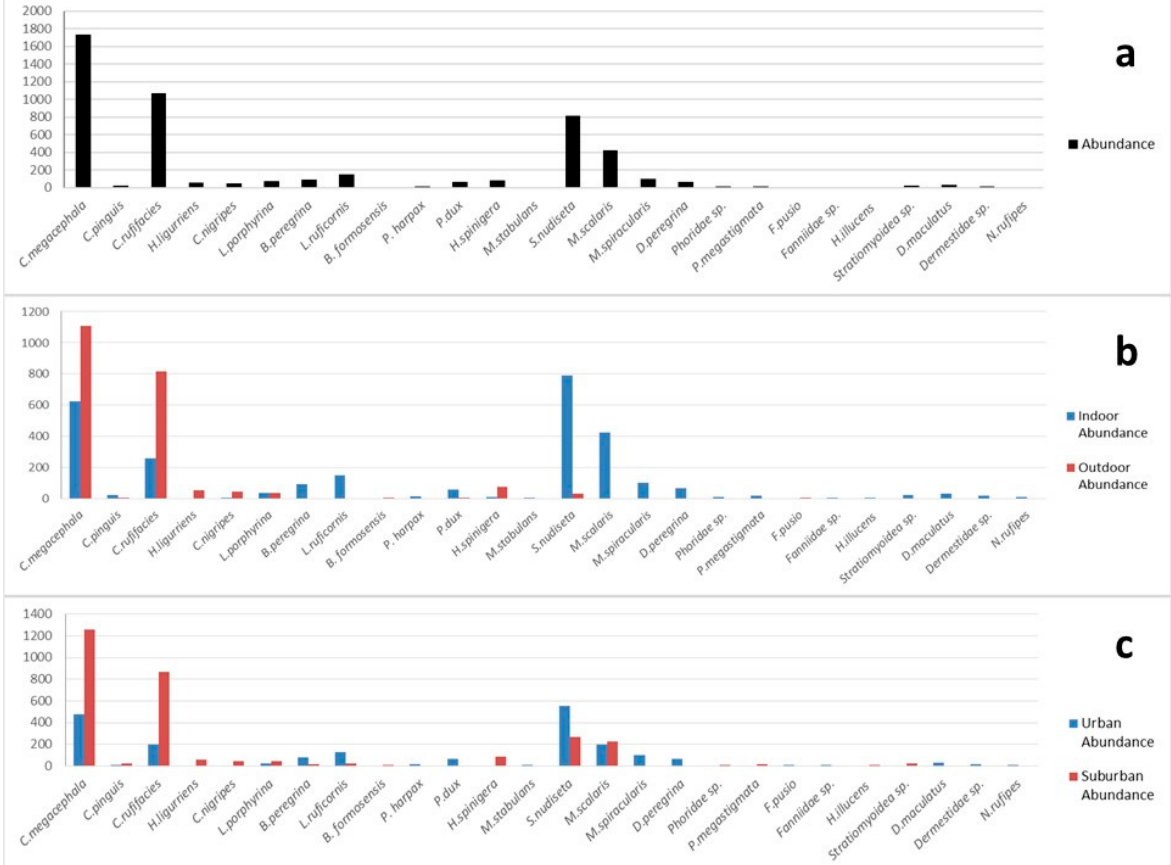
Figure 2. The abundance of the insects collected from the corpses in this study. ( a ) The total number and distribution of the specimens in the 114 cases (n = 4949); ( b ) comparison of species abundance on corpses between indoor (n = 2769) and outdoor (n = 2180) cases; ( c ) comparison of species abundance between urban (n = 1969) and suburban (n = 2980) areas.